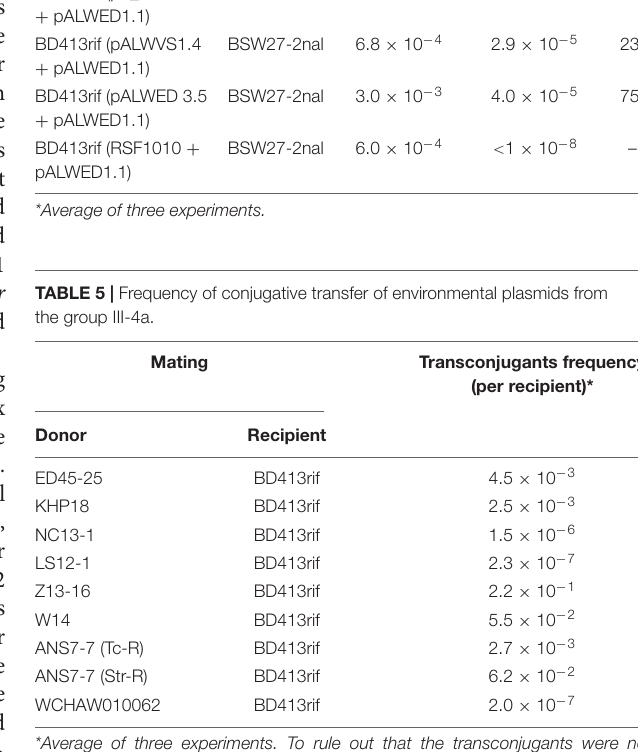
TABLE 4 | Mobilization of different small plasmids by pALWED1.1. Mating